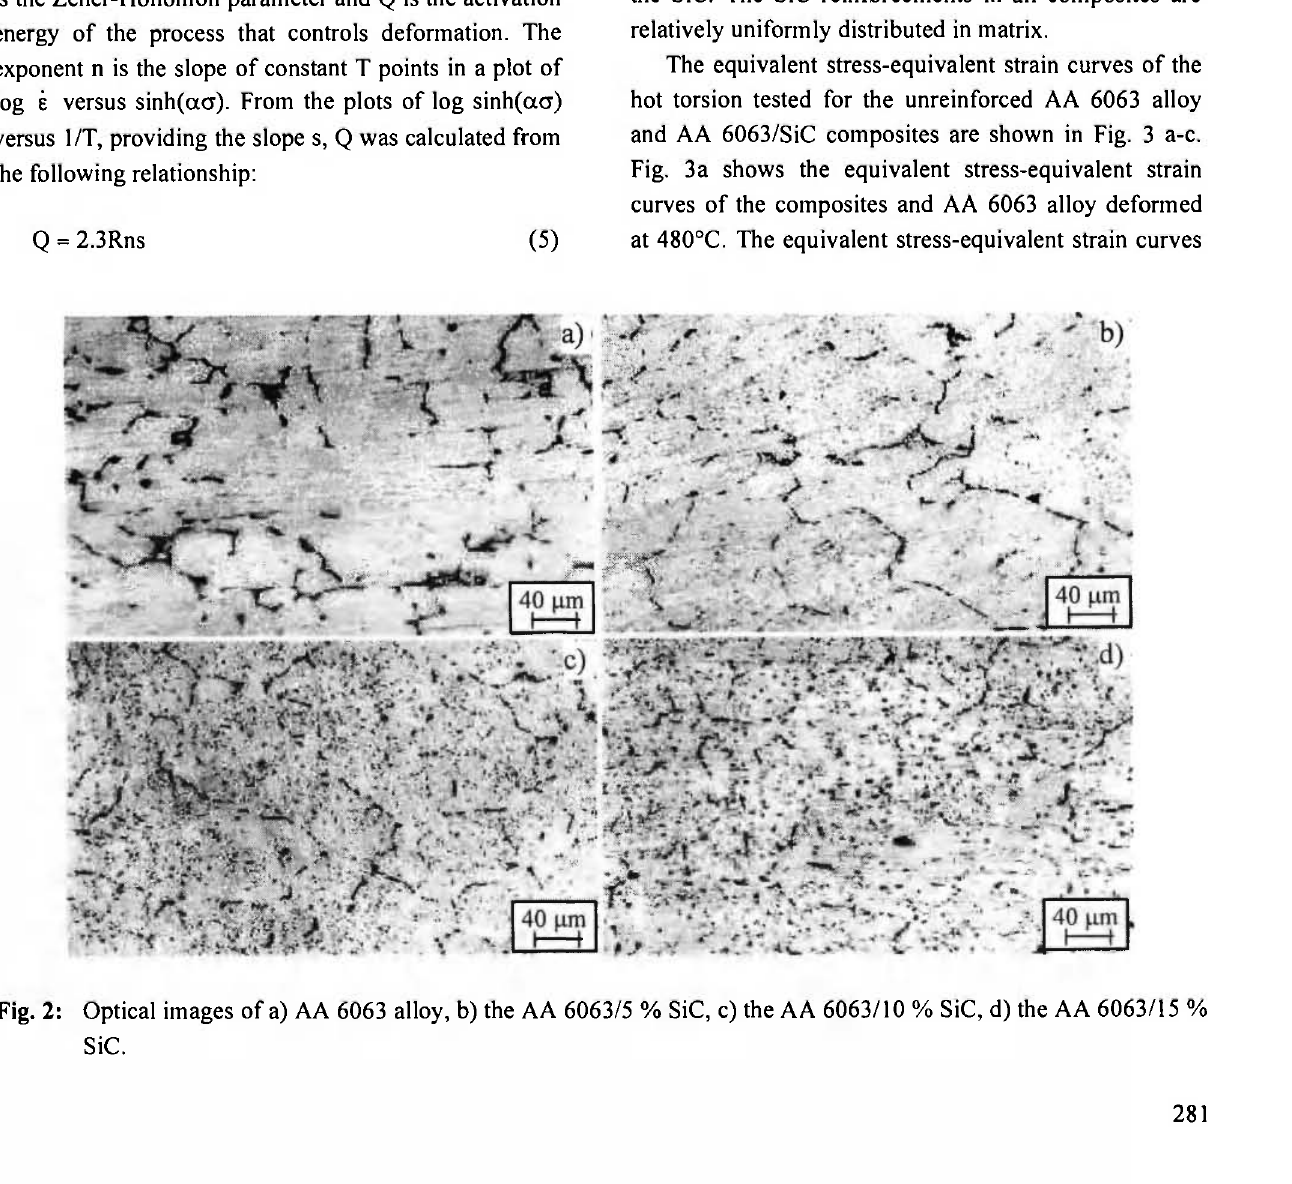
Fig. 2: Optical images of a) AA 6063 alloy, b) the AA 6063/5 % SiC, c) the AA 6063/10 % SiC, d) the AA 6063/15 %